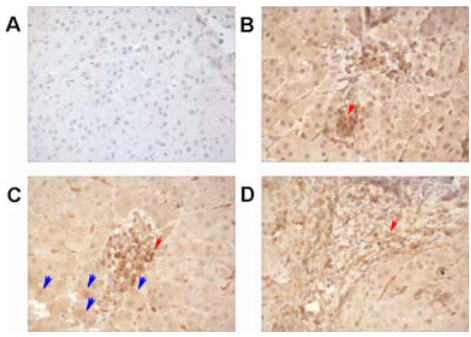
Figure 9. Expression of PI-9 in liver tissue from patients with chronic hepatitis C. Liver specimens obtained from diagnostic biopsy were stained for PI-9 expression as described in the methods. A ) Representative negative isotype control. B–D ) PI-9 was detected in the majority of hepatocytes. Stronger PI-9 expression, as expected, was seen within the mononuclear infiltrate (highlighted by red arrows), while all the hepatocytes stained positively, albeit at a lower level (the strongest are highlighted by blue